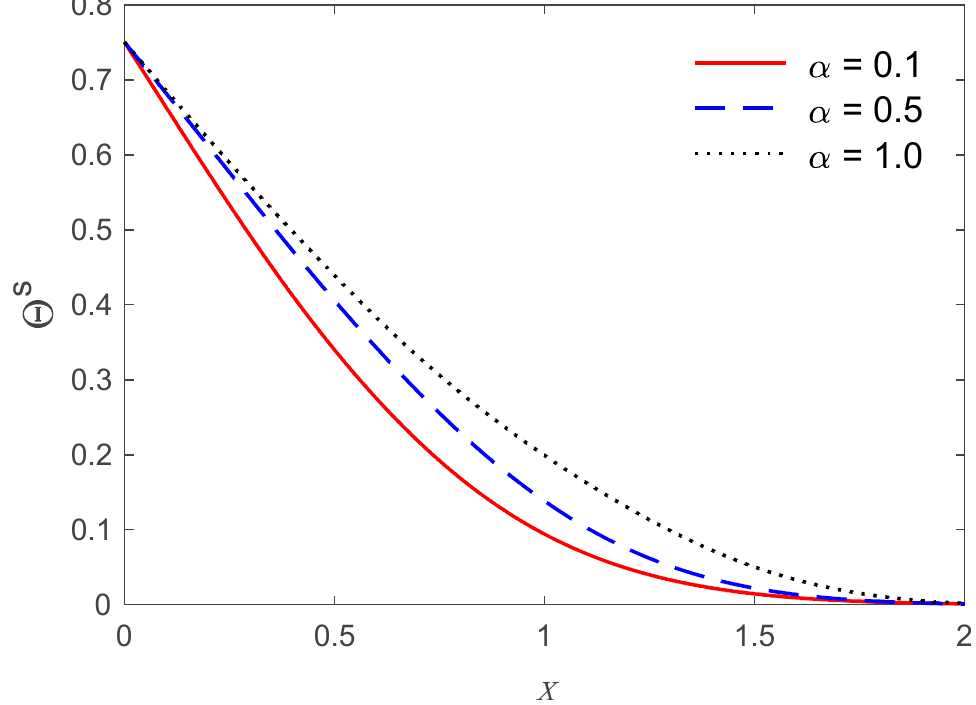
Figure 2. The variations of temperature of solid Θ (cid:3046) via 𝑥 for three values of fractional parameter.